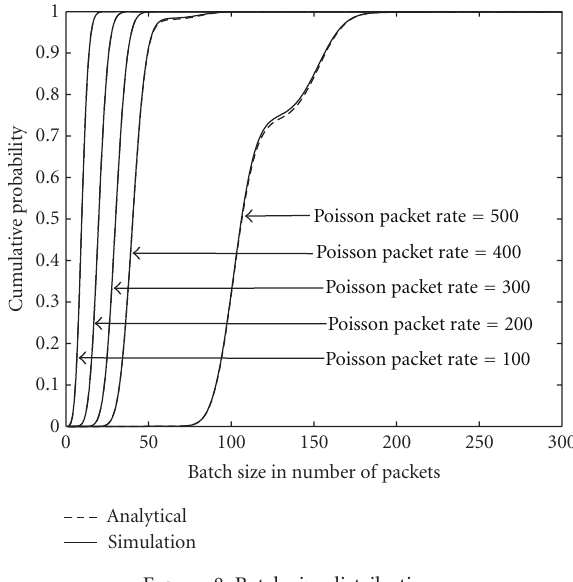
Figure 8: Batch size distribution.